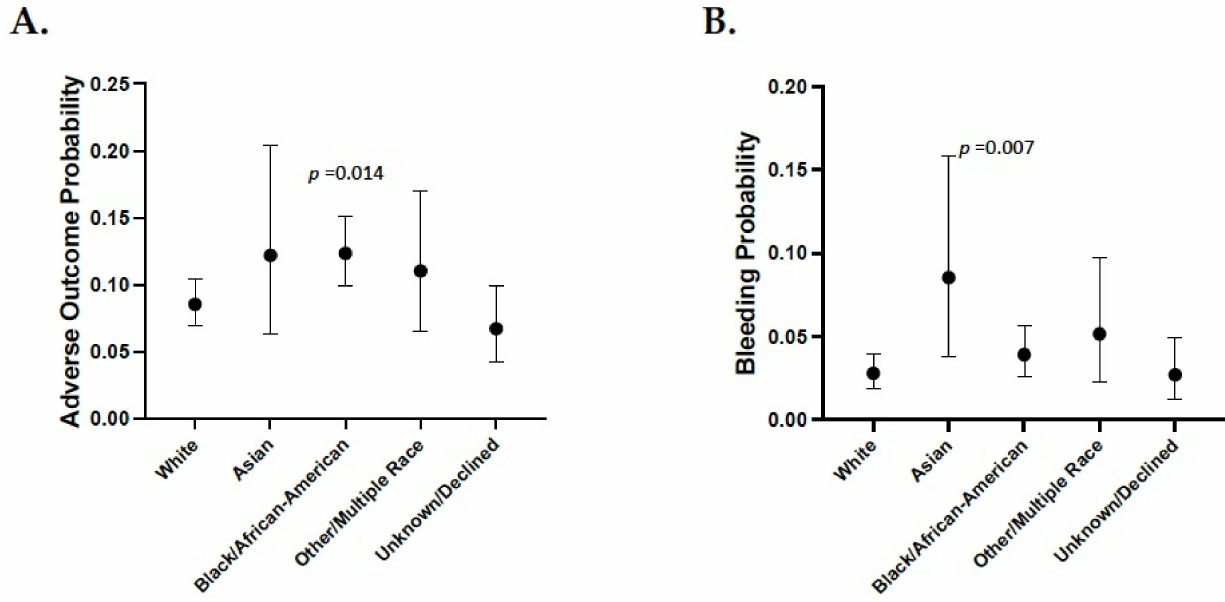
Figure 1. Race-only model for warfarin adverse events and bleeding events. Shown is the probability of experiencing any adverse outcome ( A ) or bleeding events ( B ) while taking warfarin based on race only. All comparisons used the White group as the